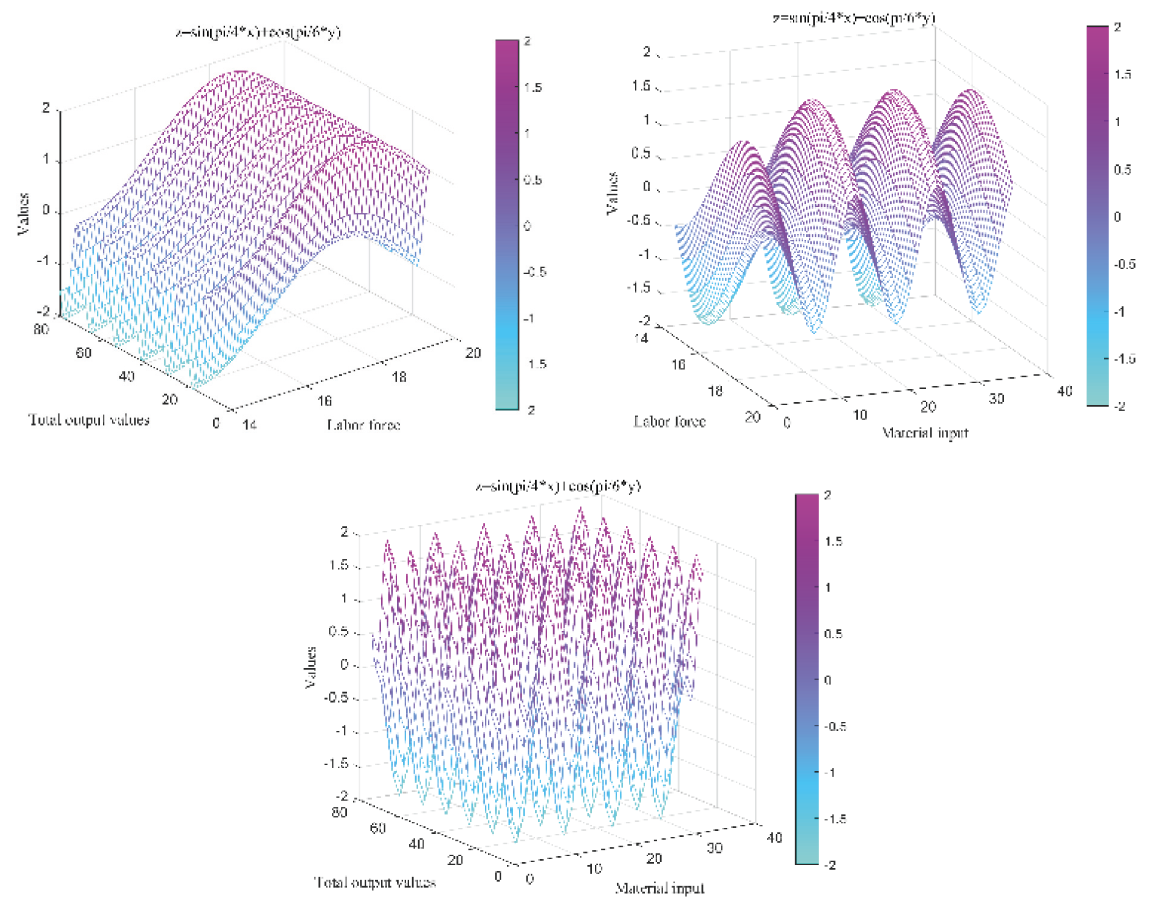
Figure 9: Interrelationships between data